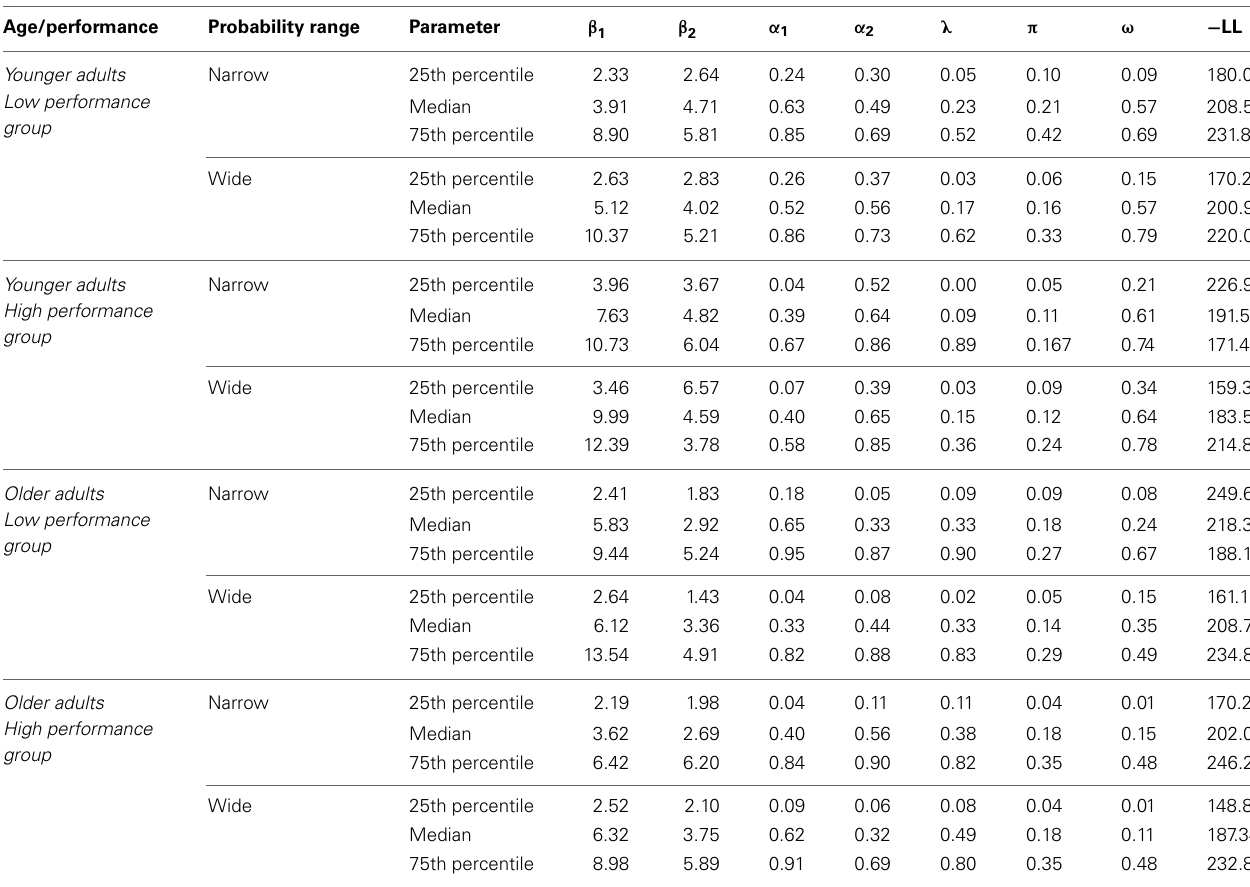
Table 2 | Computational model parameters (Median, 25th and 75th percentile) as a function of Age group (Younger older adults) and WM Performance group (low performers, high performers) and Transition probability range (narrow, wide).